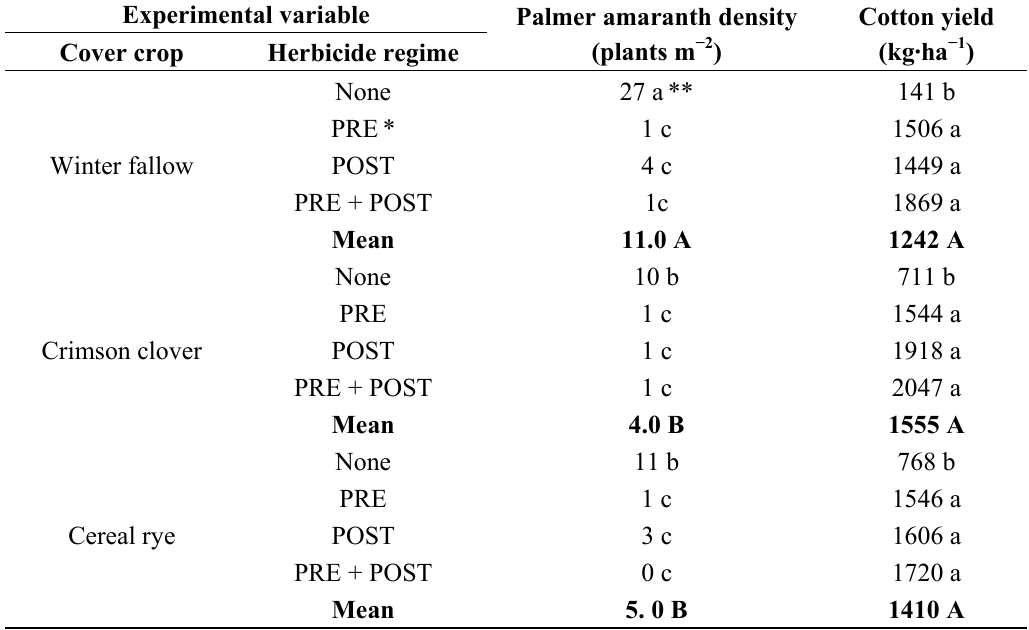
Table 4. Influence of cover crop and herbicide regime on BR * Palmer amaranth density at 6 WAP and cotton yield with soil-inversion and three production years’ data